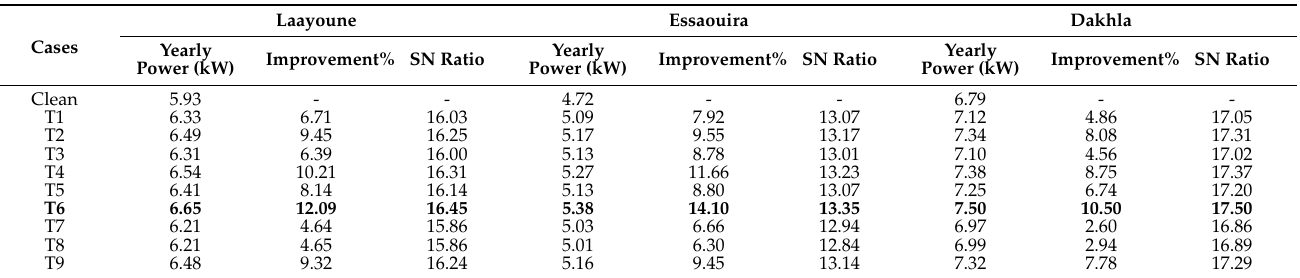
Table 8. Comparison of the yearly power generation and SN ratios for all experiments at three different